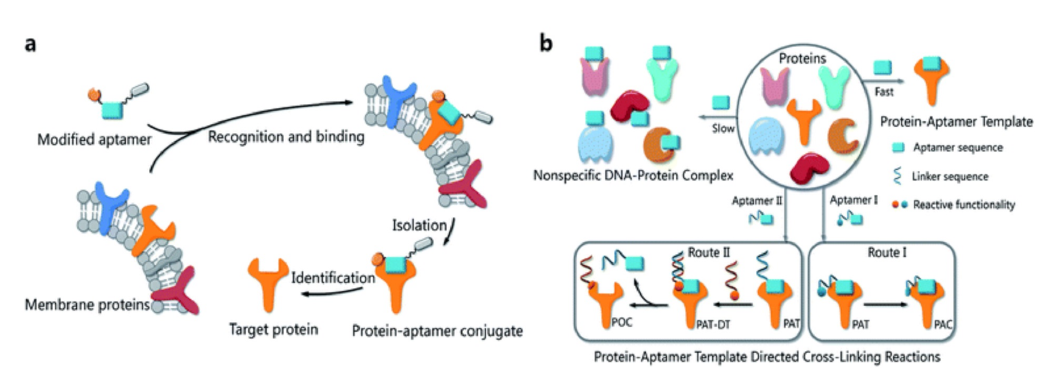
Figure 16. Schematic illustration of ( a ) one-step bioorthogonal reaction for biomarker discovery; ( b ) PAT-directed reactions for the preparation of protein-aptamer conjugates (PAC, route I) or protein-oligonucleotide conjugates (POC, route II). Reprinted with permission from © (2016) Royal Society of Chemistry